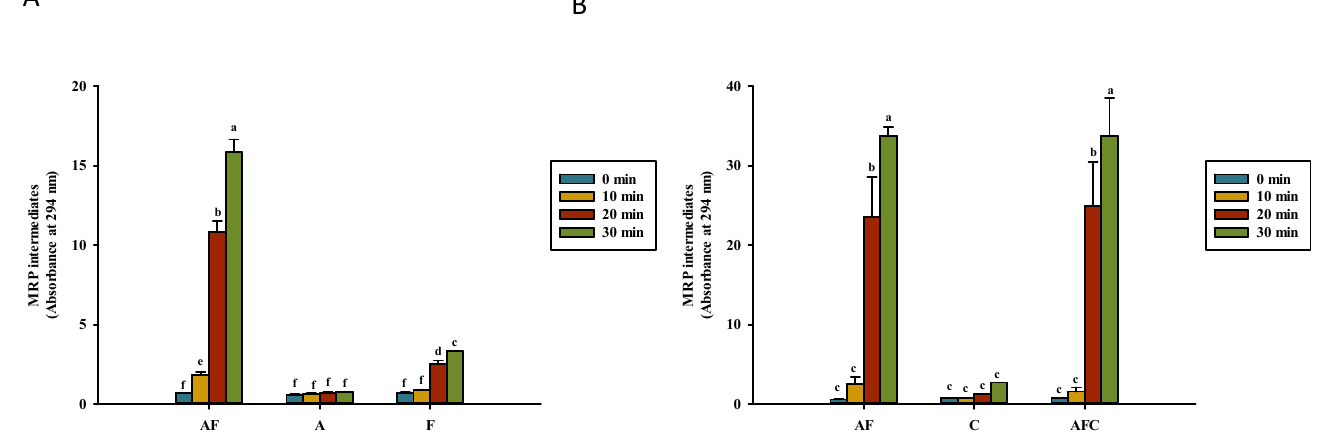
Figure 1. Maillard reaction product (MRP) intermediate development (OD 294 ) for various groups upon heating in ( A ) water and ( B ) acetic acid. AF, asparagine and fructose; A, asparagine; F, fructose; C, chitosan; AFC, asparagine, fructose and chitosan. Data represent the means of three replicates, and error bars indicate standard deviation. Bars followed by a common letter are not significantly different according to the Dunn’s test at the 5% level of significance.